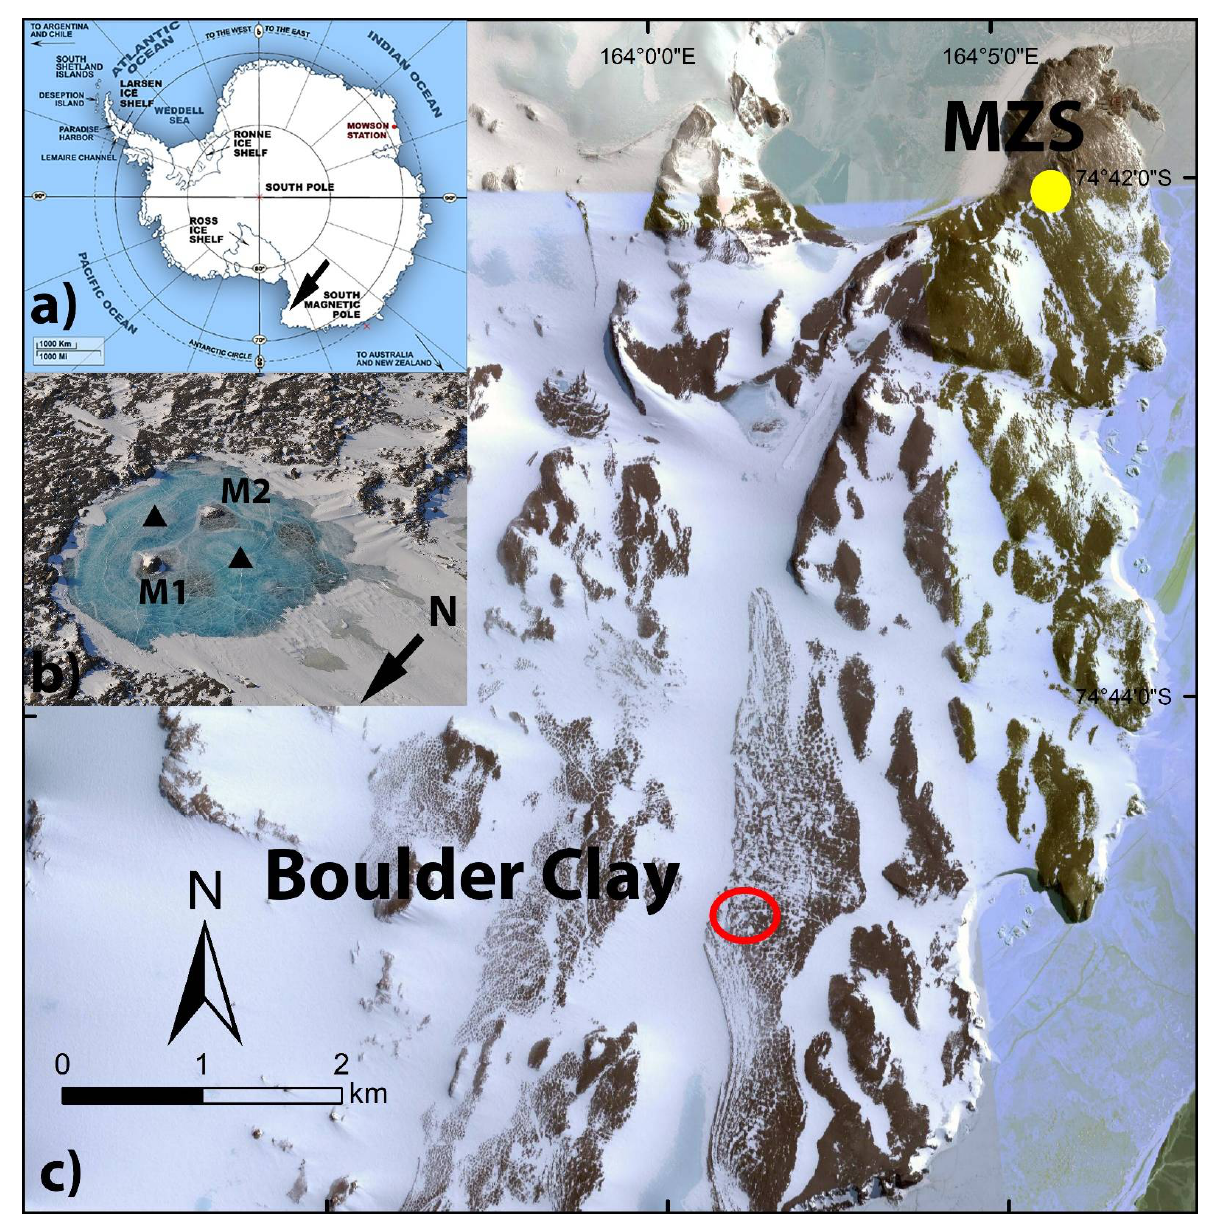
Figure 1. Location of the study area. ( a ) Location of Northern Victoria Land (black arrow), ( b ) helicopter view of the two frost blisters and the two icing blisters (black triangles), ( c ) Boulder Clay satellite imagery (Google Earth ® satellite imagery of 2014). The lake is approximatively 6 km south of the Italian station (MZS) and marked by the red circle. The yellow dot indicates the automatic weather station (AWS) “Eneide”.